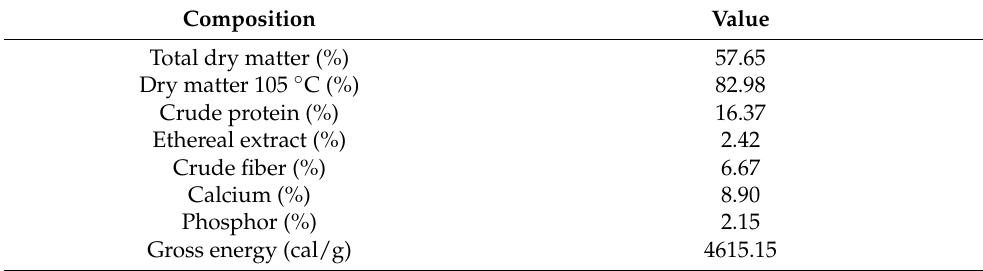
Table 1. Nutritional composition of Artemia nauplii used in the experiment.